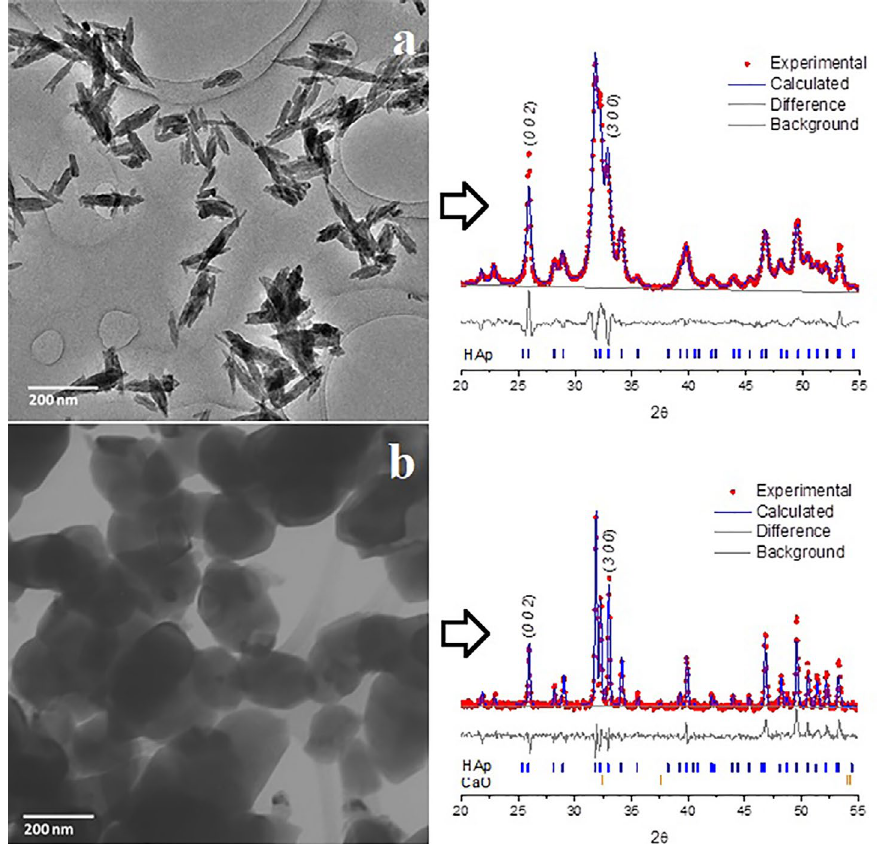
Figure 1. TEM images of (a) as-synthesized hydroxyapatite (HA) particles and (b) the same particles after calcination at 1150°C for 4 h. Rietveld refinement of the XRD patterns obtained from the as-synthesized HA ( GoF : 3.05) and after calcination ( GoF : 2.46) are shown.